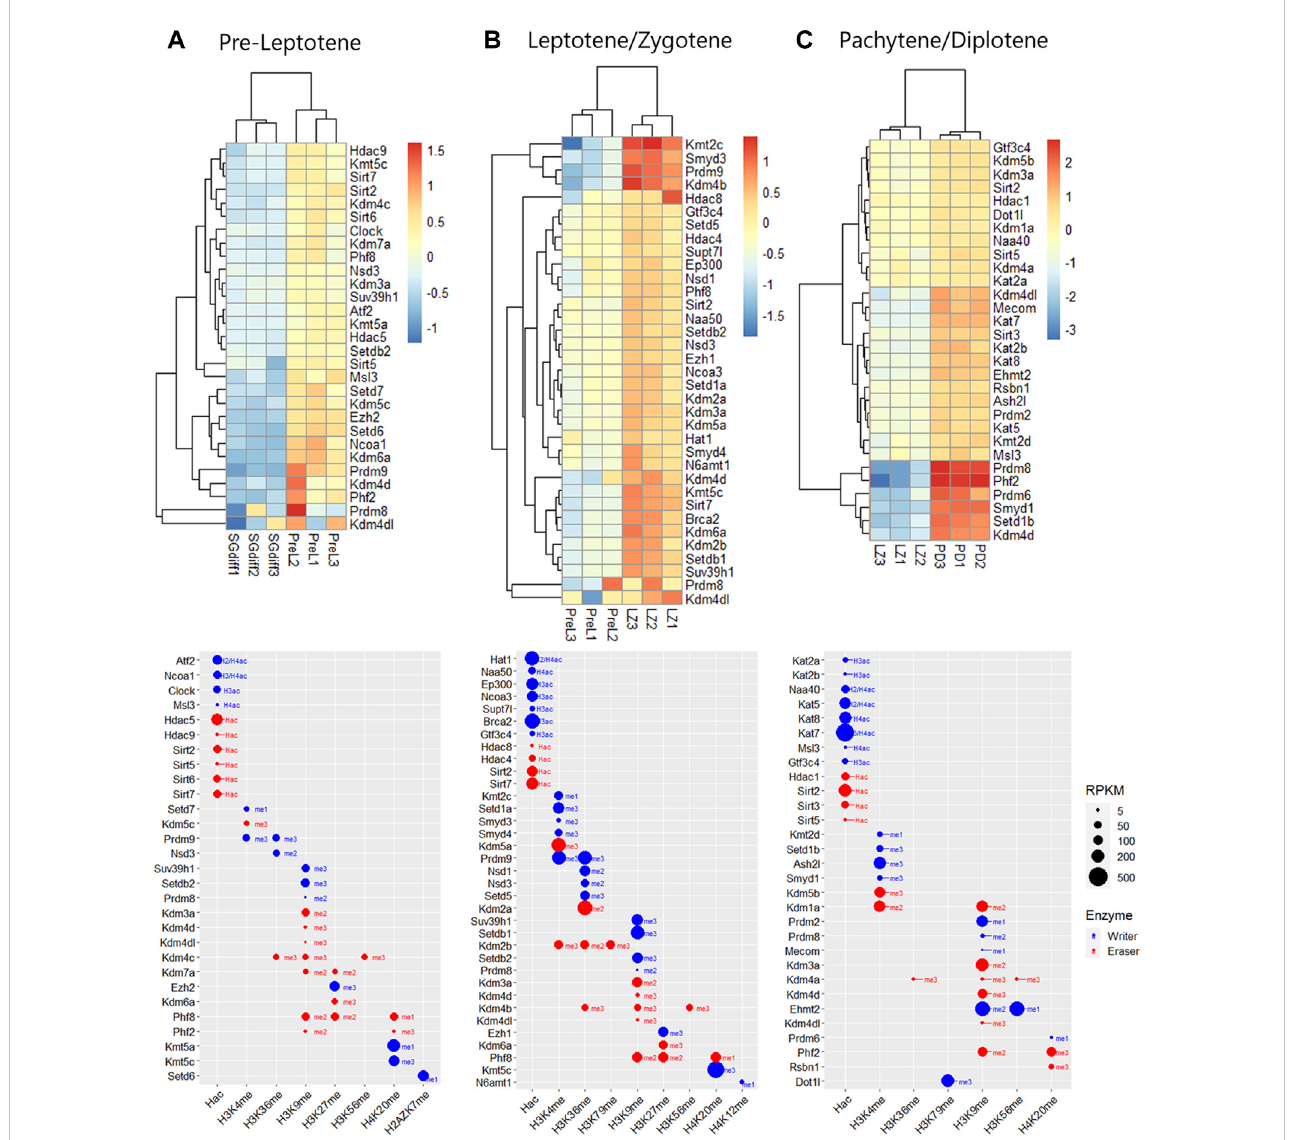
FIGURE 5 Epigenetic histone K writers and erasers upregulation at meiosis prophase I. The upper panels indicate the heatmap showing z-score values and the lowerpanels indicate thebubble chart showing enzymes RPKM values, inPreL (A) , LZ (B) and PD (C) spermatocytes.Bluedots: writers,red dots:erasers.PreL: pre-leptotene spermatocytes, LZ: leptotene/zygotene spermatocytes, PD: pachytene/diplotene spermatocytes. The me1/2/3 reference for each dot indicates the highest methyl position reported for each lysine methylation enzyme. The H2/3/4ac reference indicates the histone target reported for each lysine acetylation writer. Hac indicates that lysine acetylation eraser was reported to erase acetylation on all histones